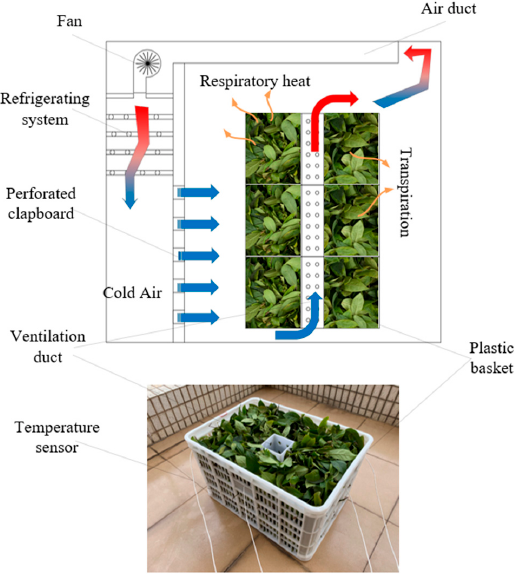
Figure 1. When the fan is running, air from the fresh-keeping area reaches the refrigeration area through the air duct and is cooled by the refrigerating system.